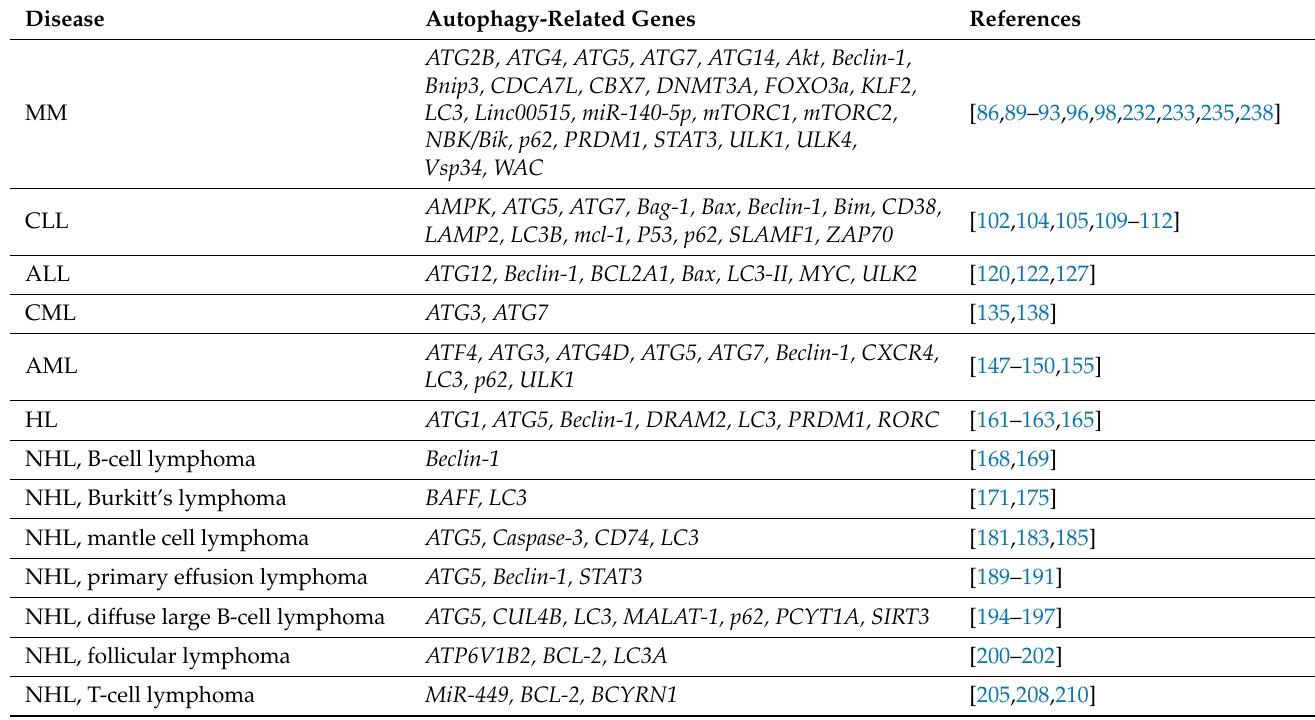
Table 2. Autophagy-related genes in hematological